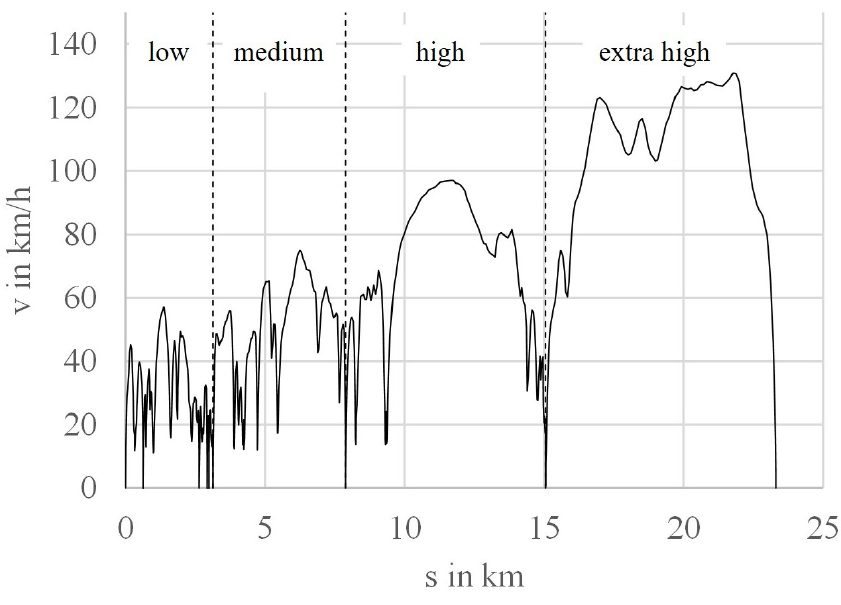
Figure 1. WLTC speed profile v as a function of the distance driven s (VW e-Up!